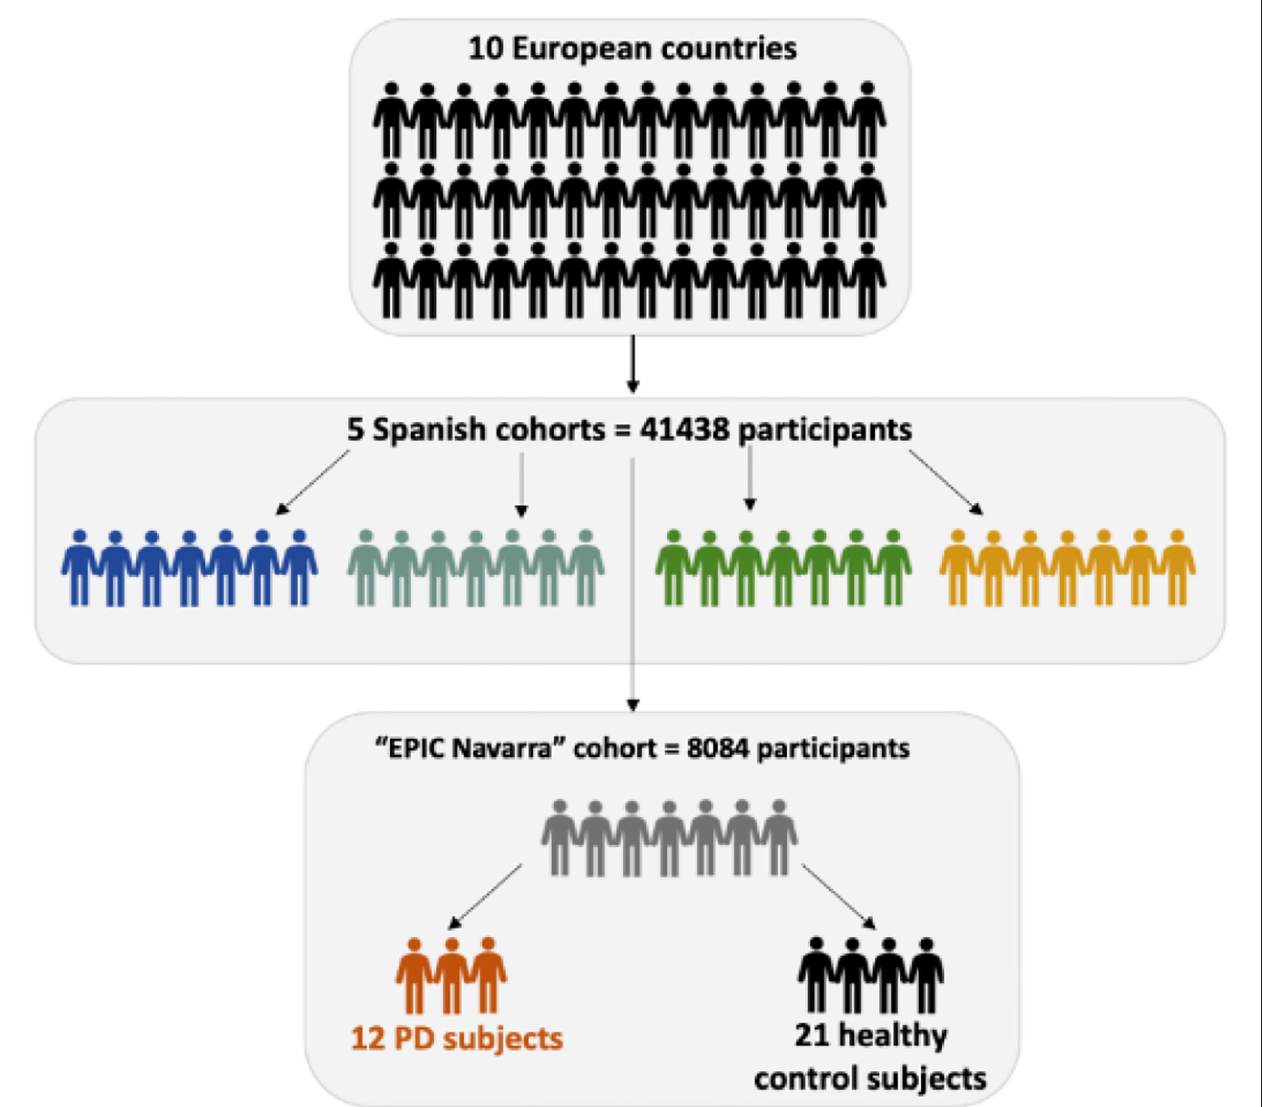
FIGURE 3 | Schematic structure of the European Prospective Investigation into Cancer and Nutrition (EPIC) study and the samples used in